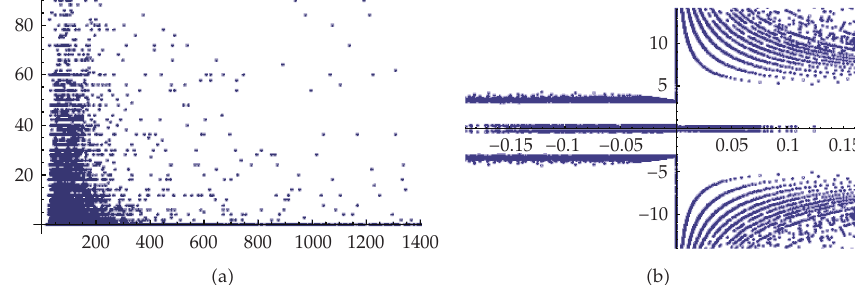
Figure 10: (cid:5) a (cid:6) The Hodge numbers, with h 1 , 1 (cid:7) h 3 , 1 as the abscissa and h 2 , 1 , the ordinate, of the “self-mirror” Calabi-Yau fourfolds. (cid:5) b (cid:6) The position of the roots of the Poincar´e polynomials of these 5009 spaces.